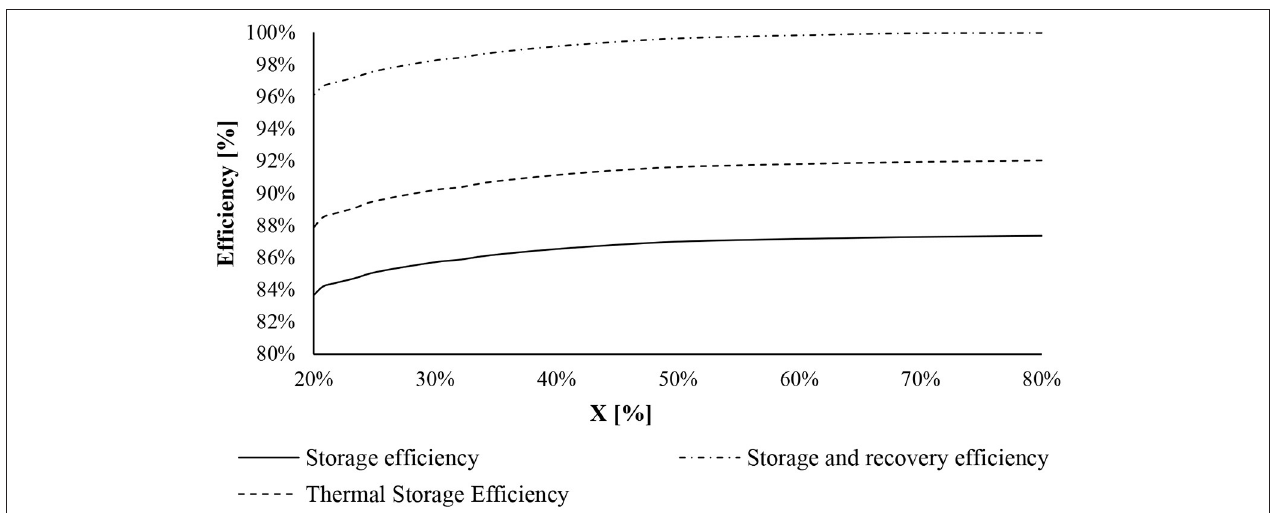
FIGURE 12 | Efficiencies of the CaL storage system at a different value of CaO conversion: storage efficiency (full line), thermal storage efficiency (dotted line), and storage and recovery efficiency (dotted-point line).